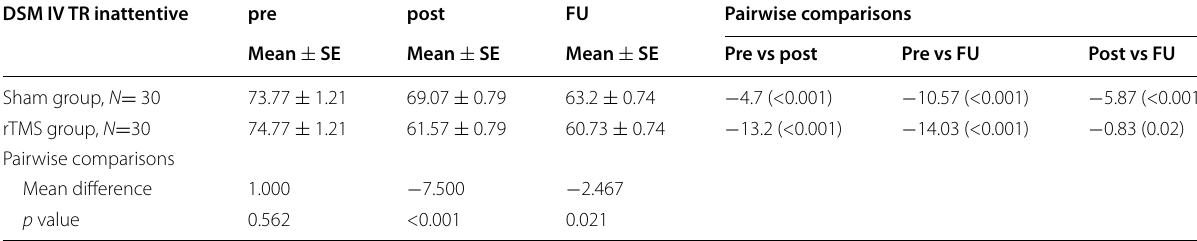
Table 3 Comparing mean DSM IV inattentive T score between the 2 groups at different times